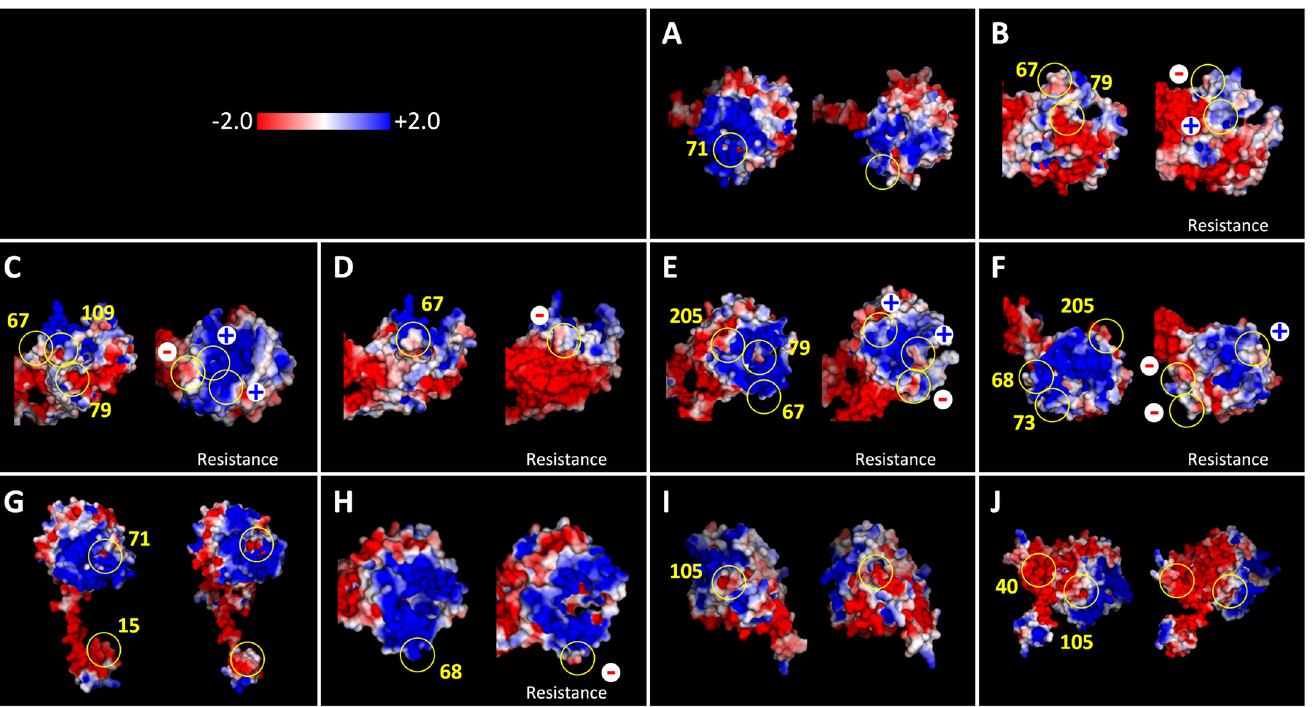
Fig 6. Poisson-Boltzmann electrostatic potential mapped onto the Van der Waals surfaces of pvr2/eIF4E1 protein. The electrostatic potential of the protein encoded by the reference allele pvr2 + (left) is compared with that of alleles (right) pvr1 + (A), pvr2 1 (B) pvr2 2 (C), pvr2 4 (D), pvr2 7 (E), pvr2 9 (F), pvr2 17 (G), pvr2 23 (H), pvr2 24 (I) and pvr2 25 (J). Panels A, G, I and J compare the protein encoded by pvr2 + with those encoded by potyvirus susceptibility alleles, while panes B-F and H compare the protein encoded by pvr2 + with those encoded by potyvirus resistance alleles.